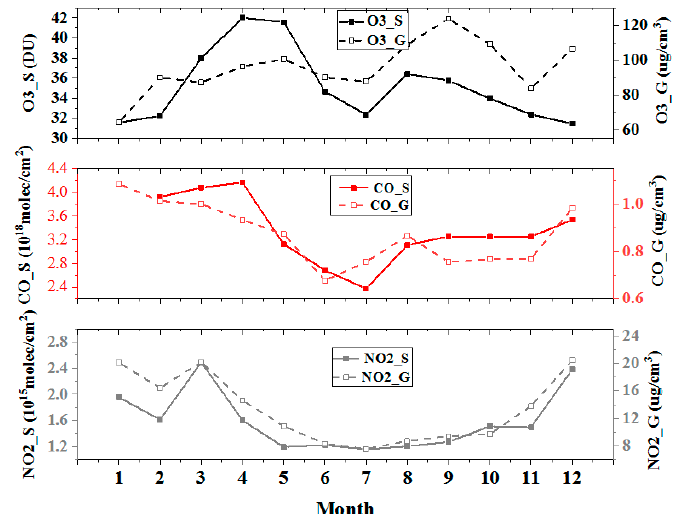
Figure 8. Monthly averaged satellite observed TCO (O 3 _S), CO (CO_S) and NO 2 (NO 2 _S) and ground observed surfaced ozone (O 3 _G), CO (CO_G) and NO 2 (NO 2 _G) in 2016.